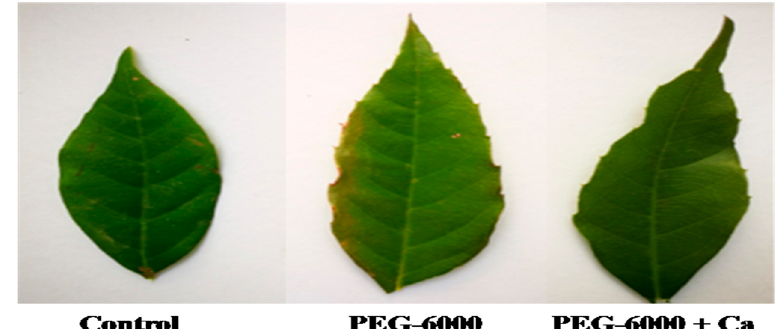
Figure 1. Typical pictures of plant leaf with PEG-6000 and Ca 2+ treatment after 72 h.